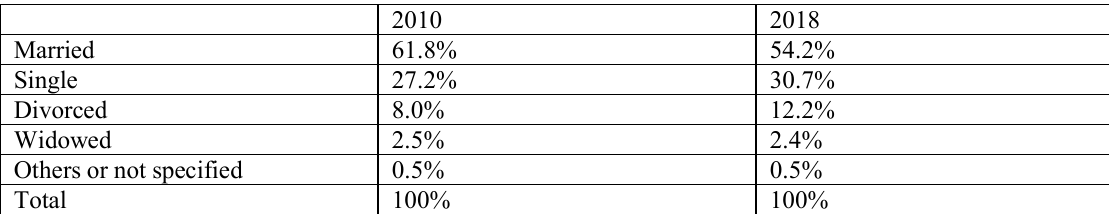
Table 9: Proportions of adults with different marital status among the low-literate population 2010 2018 Married 61.8% 54.2% Single 27.2% 30.7% Divorced 8.0% 12.2% Widowed 2.5% 2.4% Others or not specified 0.5% 0.5% Total 100%